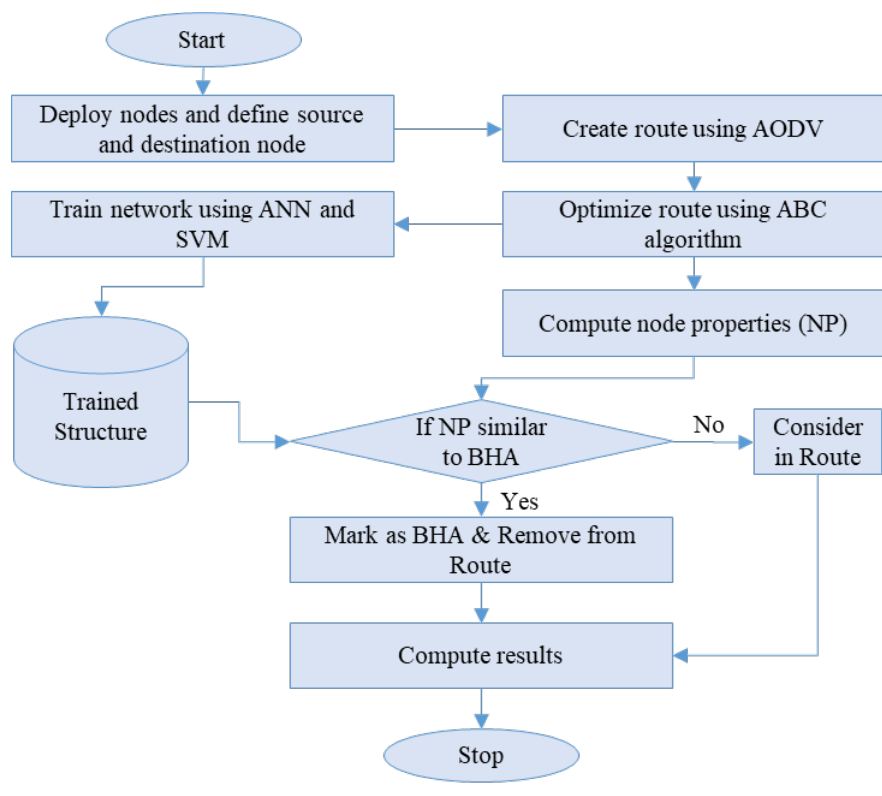
Figure 2. The flow of proposed work.